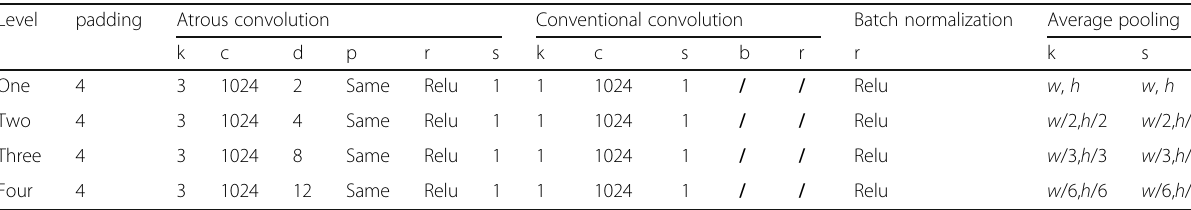
Table 1 Hyperparameter settings for operation within a four-level pyramid Level padding Atrous